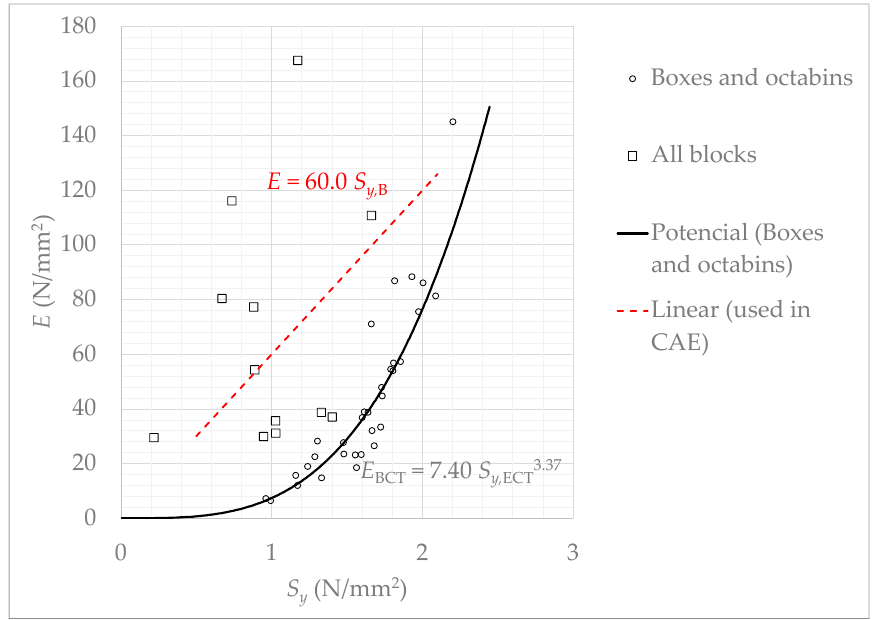
Figure 10. Deformation modulus for billets and boxes.